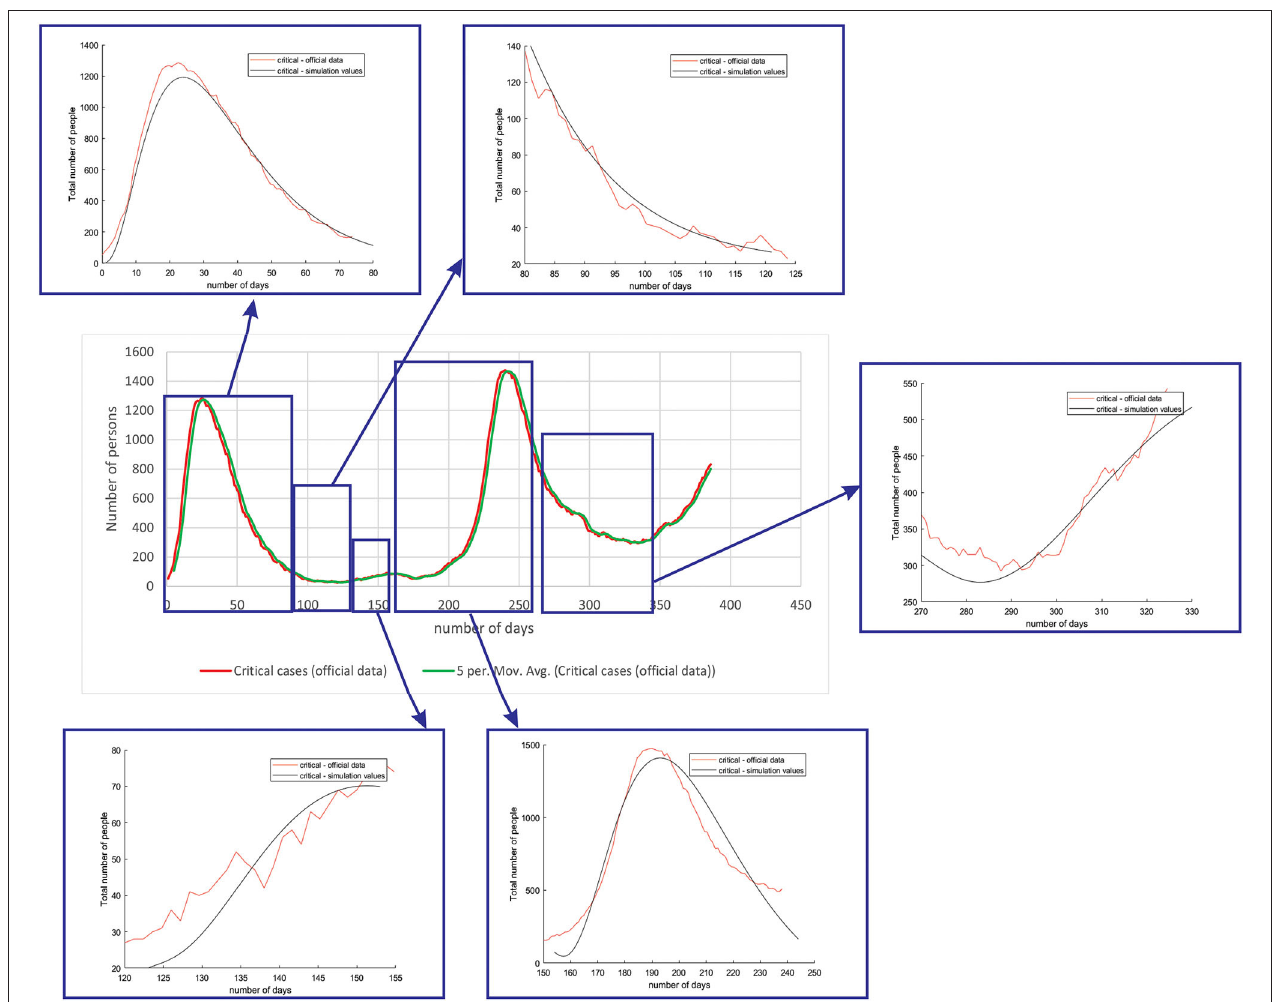
Figure 11 . Loss function is presented in each iteration of the cross-validation